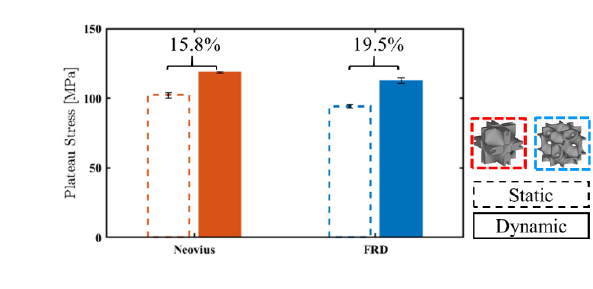
Fig. 6 . Plateau stress of Neovius and FRD TPMS lattices under static and dynamic